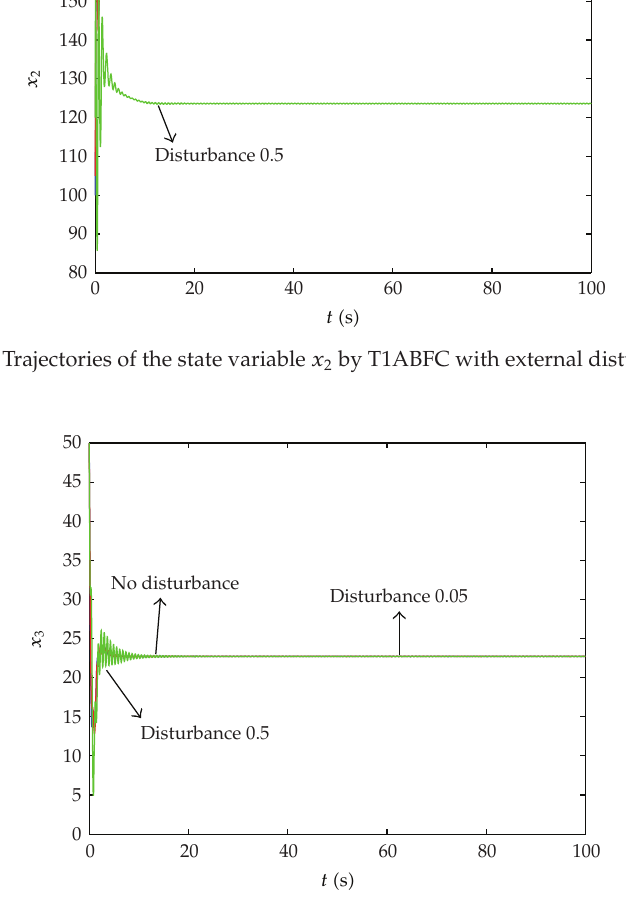
The second adaptive laws are designed